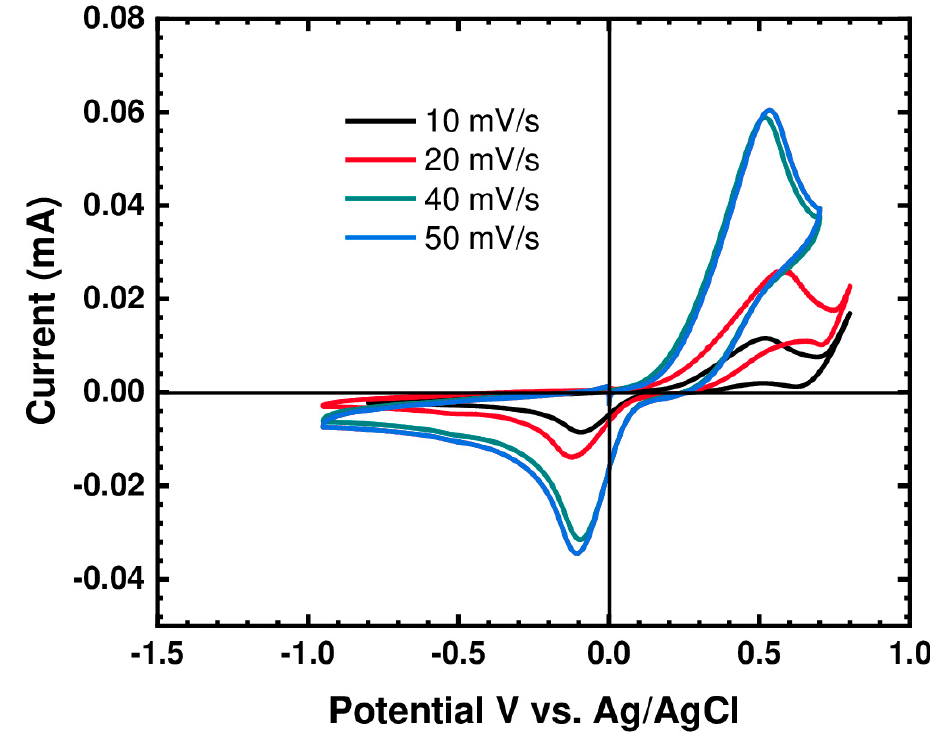
Figure 4. CV of (BMIM)(HQS) at 30 ◦ C using glassy carbon working electrode, at various scan rates.